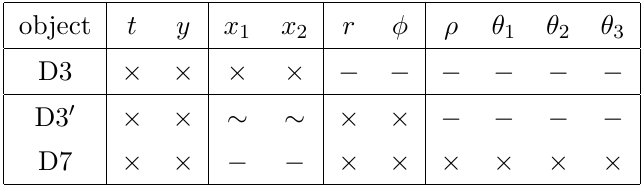
BPS brane system underlying the intersection of D3 0 – D7 branes intersecting D3 Table 2 . The 1 8 branes. The ∼ denotes smearing